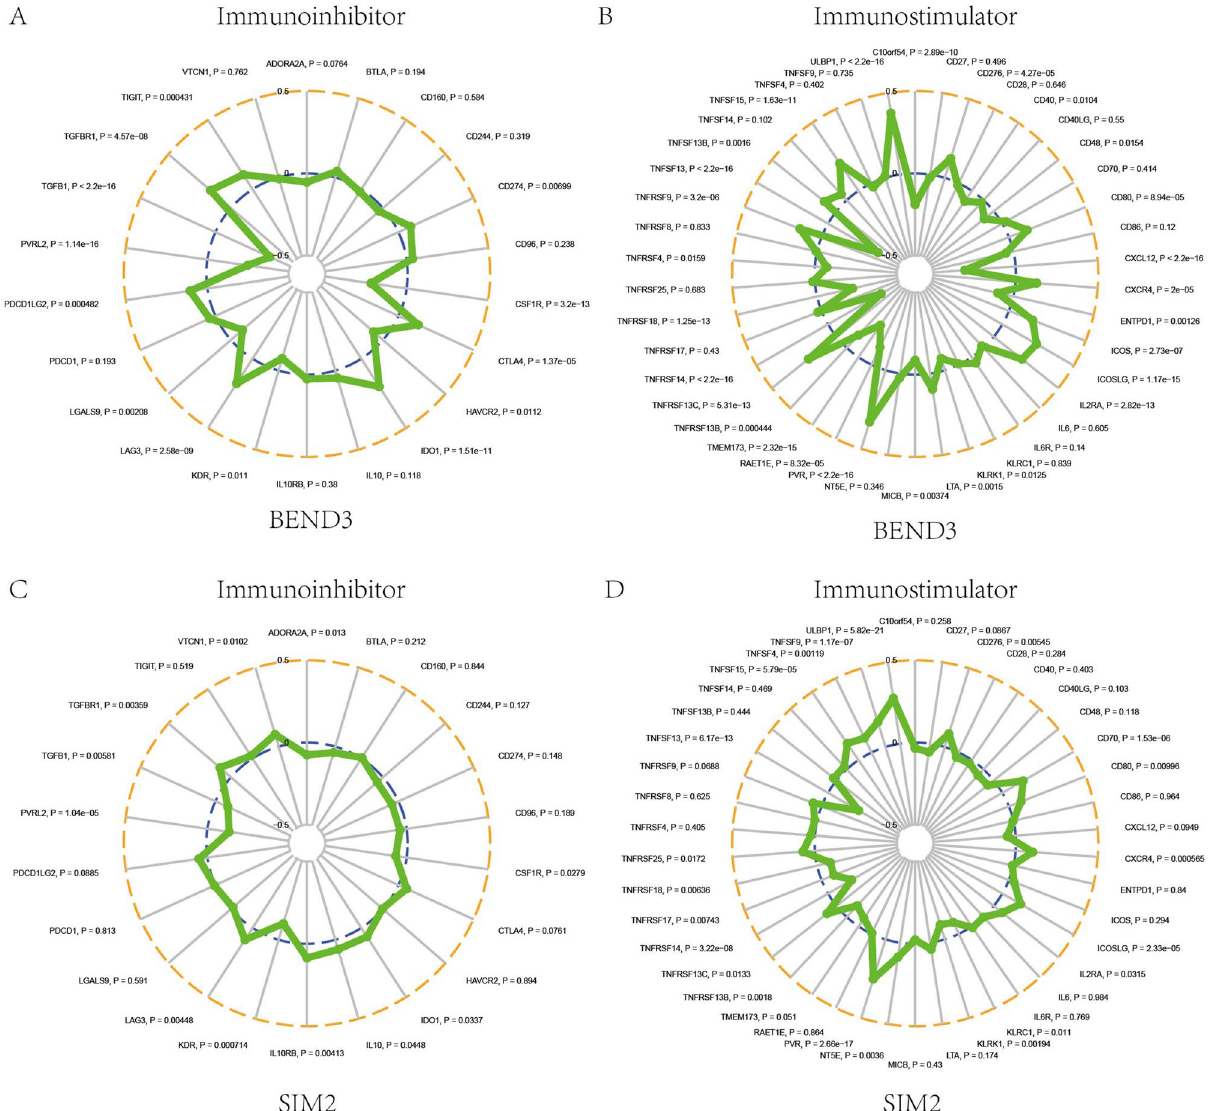
Figure 14. Comprehensive analysis of BEND3 and SIM2 and various immune checkpoints based on the TISIDB database. ( A – B ) The correlations of BEND3 with immune inhibitor genes and immune stimulator genes. ( C – D ) The correlations of SIM2 with immune inhibitor genes and immune stimulator